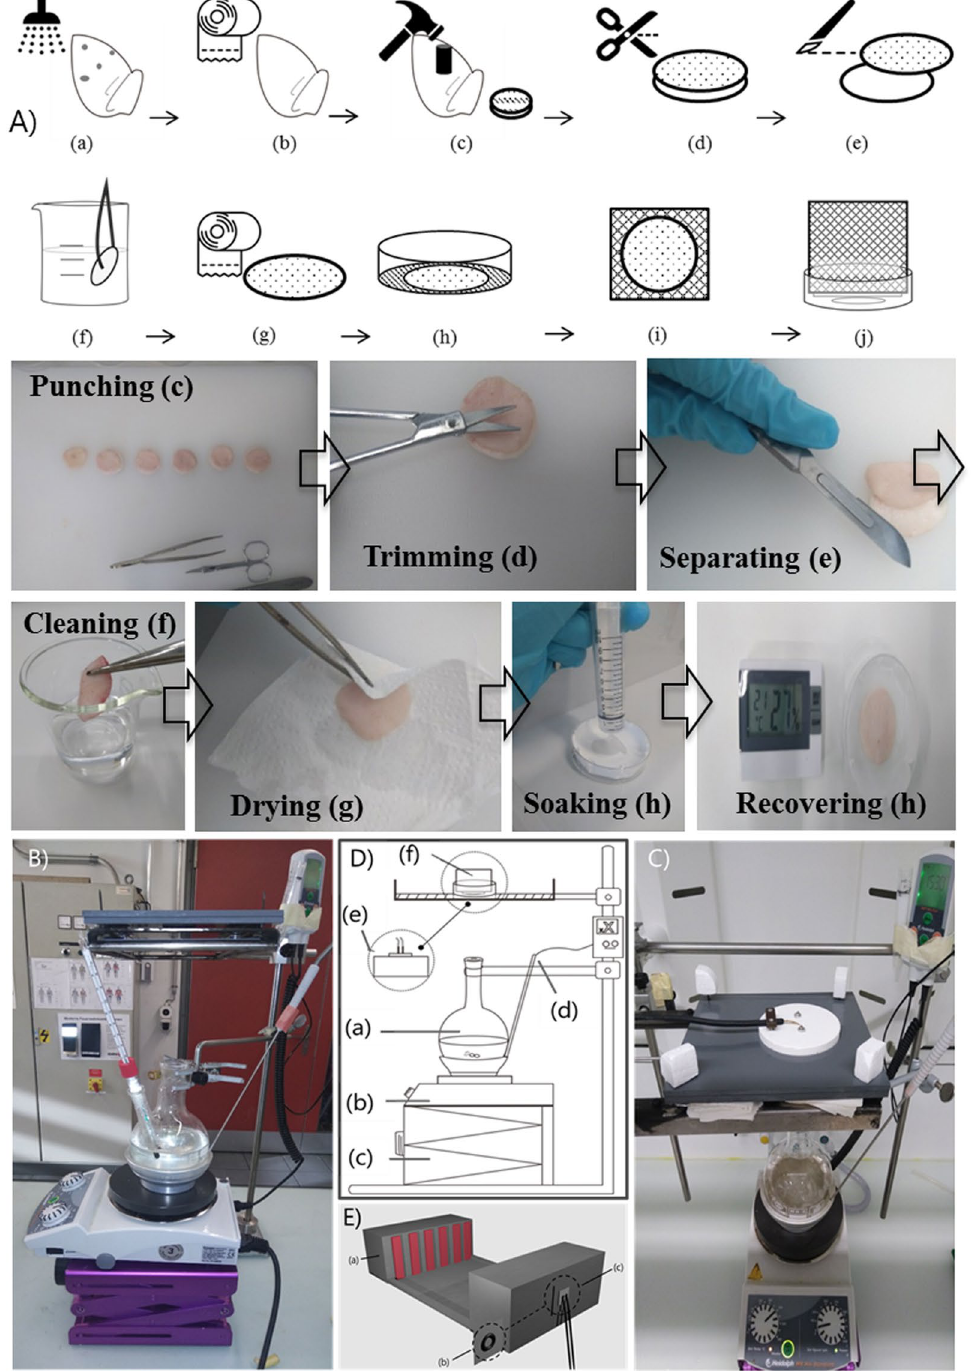
Figure 3. ( A ) Illustrated procedures for sample preparation and measurements. (a) Washing of the ear (b) Drying of the ear (c) Punching sample (d) Trimming the hair (e) Separating skin from cartilage (f) Cleaning sample (g) Drying sample (h) Leave the sample to recover (i) Attaching sample to plastic foam (j) Fitting into skin sample holder. Illustration of the test apparatus for calibration ( B ) and skin sample steam exposure ( C ) with description of the test apparatus ( D ): (a) Beaker (b) Hot plate (c) Lifter (d) Calorimeter system (e) Heat flux sensor (f) Sample and holder ( E ) Schematic of test apparatus for calibration and dry heat exposure: (a) Radiant heater (b) Skin sample and holder (c) In preliminary experiments, a recovery time of 1 ~ 1.5 h was found to be appropriate, considering the exposure and observation time. 1 h of recovery time was finally chosen. After recovery, the skin sample was attached to the surface of a plastic foam cube (4 cm) to relax to a natural size. For steam exposure conditions, they were then fitted into a sample holder. For the purpose of clarity, the sample preparation procedure is schemed in Fig. 3A.